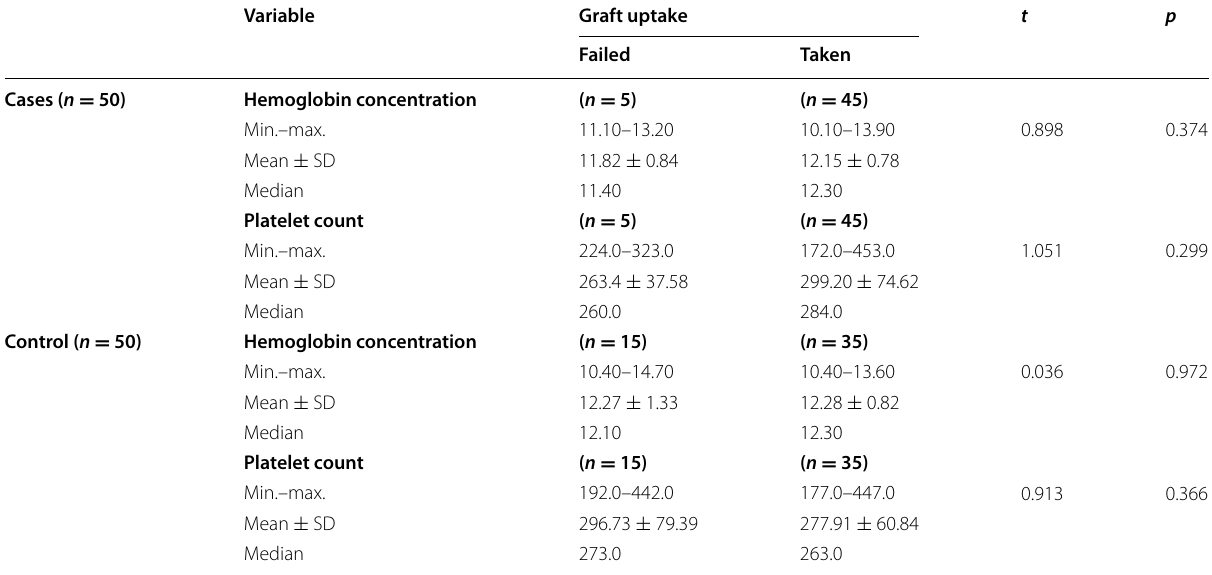
Table 4 Correlation between the graft uptake, on one hand, and hemoglobin concentration and platelet count on the other hand in each